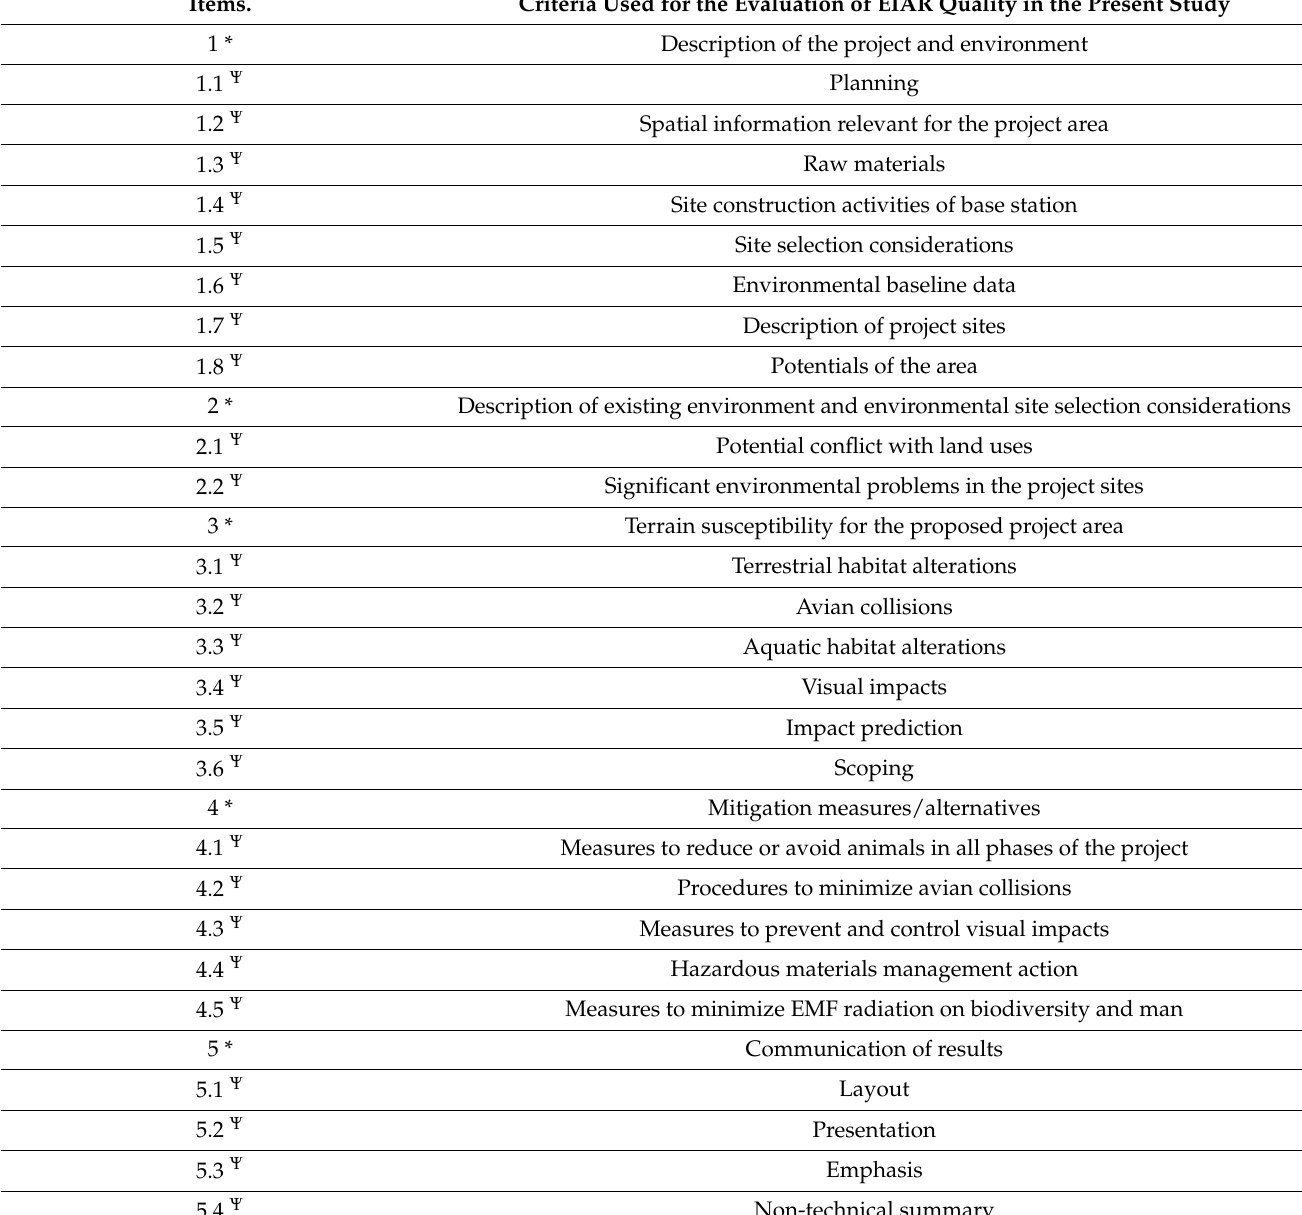
Table 3. Evaluation criteria used for the assessment of EIARs for the mobile telecommunication sector in Nigeria (* signifies the review areas and Ψ signifies the review